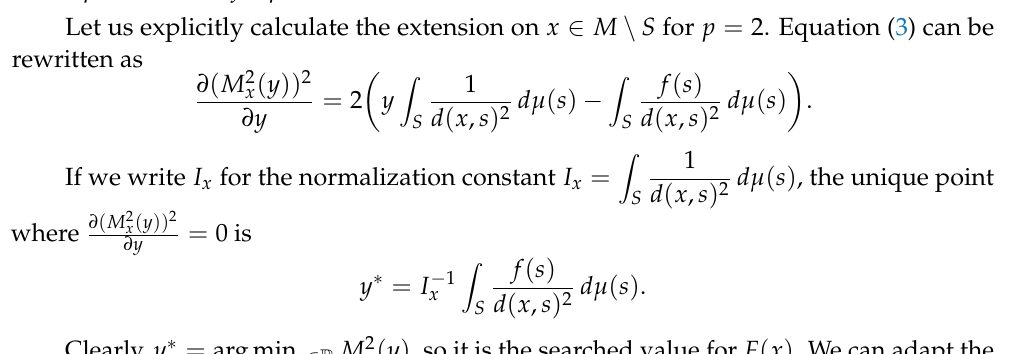
(cid:0) (cid:1) δ 1 + δ 2 + δ 3 + δ 5